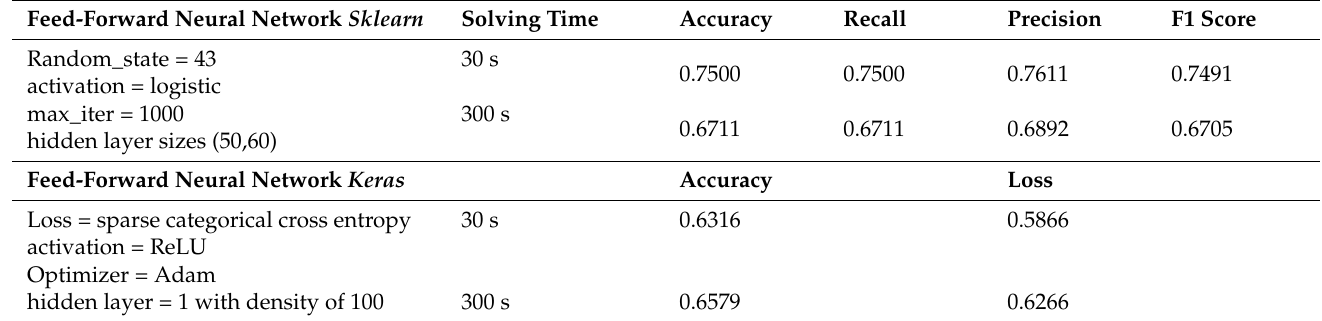
Table 9. Performance metrics of the neural network for FJSSP